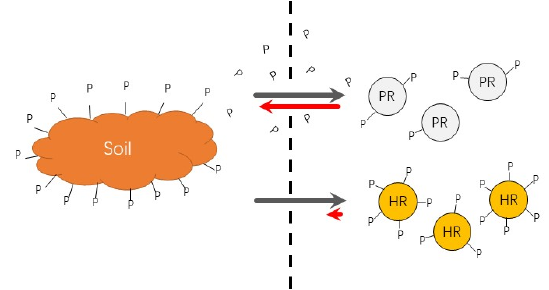
Figure 1. A schematic illustration of phosphate (P) desorption systems using pure resins (PR) and hybrid resins (HR) as a P sink. Forward and backward reactions are shown in black and red arrows, respectively. A vertical dotted line indicates a boundary between a mesh bag and a soil solution. Note that more P is retained in HR because of a small backward reaction (i.e., P release) from HR compared to that from PR.